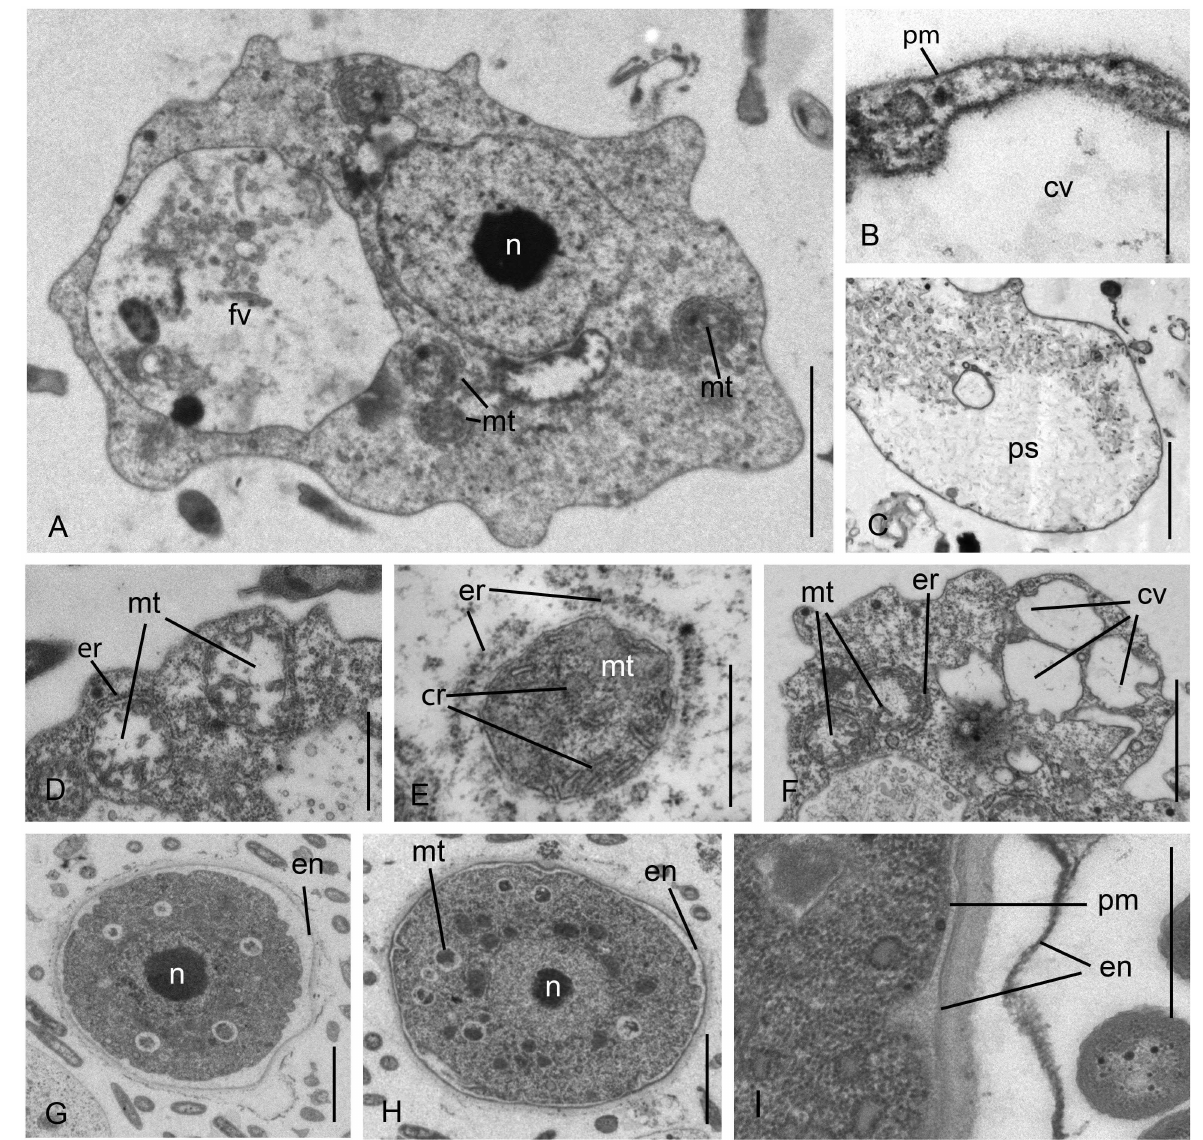
Figure 3. Ultrathin sections of amoebae and cysts (TEM). ( A )—general view, ( B )—contractile vacuole and part of cell surface, ( C )—hyaline pseudopodium, ( D , E )—mitochondrium with discoidal cristae, ( F )—small contractile vacuoles, ( G , H )— cysts, ( I )—envelope of the cyst. Abbreviations: cr—crista, en—envelope, er—endoplasmc reticulum, fv—food vacuole, mt—mitochondria, pm—plasmalemma. For explanation of other symbols, see Figure 1. Scale bar: ( A , C , F , G , H )—2 µ m, ( I )—0.6 µ m, ( D , E )—0.5 µ m, ( B )—0.2 µ